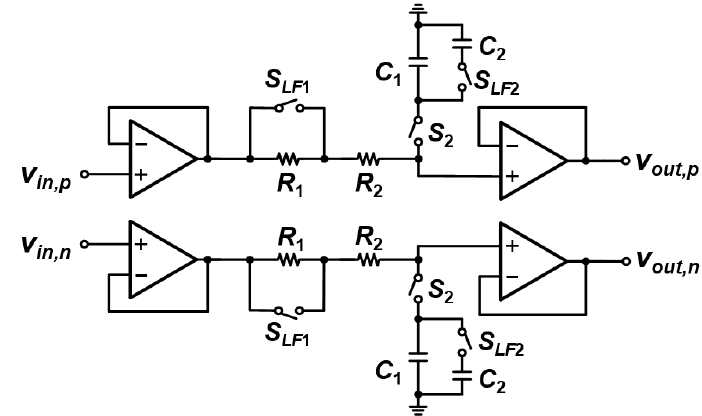
Figure 10. Circuit diagram of the